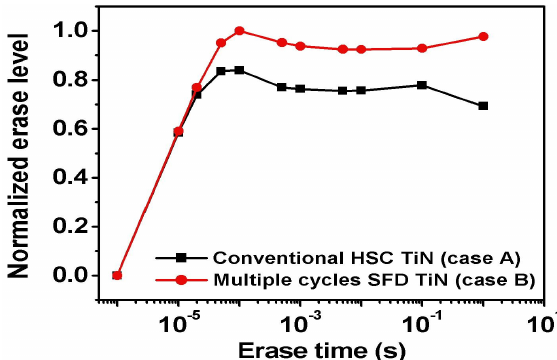
Figure 10. Normalized erase level change of devices for conventional FDC and GETiN gates.